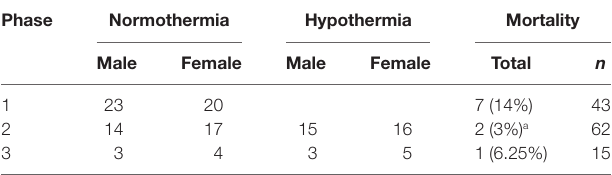
TaBle 1 | Distribution of surviving pups by treatment group in each phase and mortality. Phase normothermia hypothermia